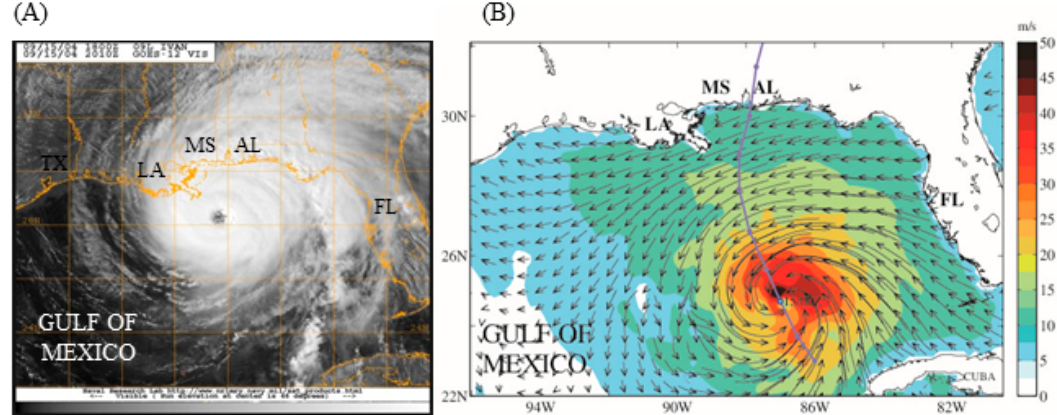
Figure 1. ( A ) GOES-12 visible satellite image of Hurricane Ivan from 16 September 2004, nearing landfall along the northern GOM coast. ( B ) COAMPS-TC wind speed (shaded) and direction (black vectors) for 0000 UTC September 15 2014 are plotted. Actual track is shown by the purple line and each waypoint represents Ivan’s center position every 12 hours, at 0000 and 1200 UTC each day.